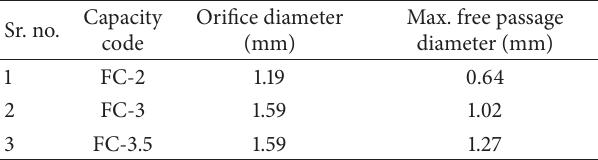
Table 1: Specifications of full cone spray nozzles. Capacity Sr. no.